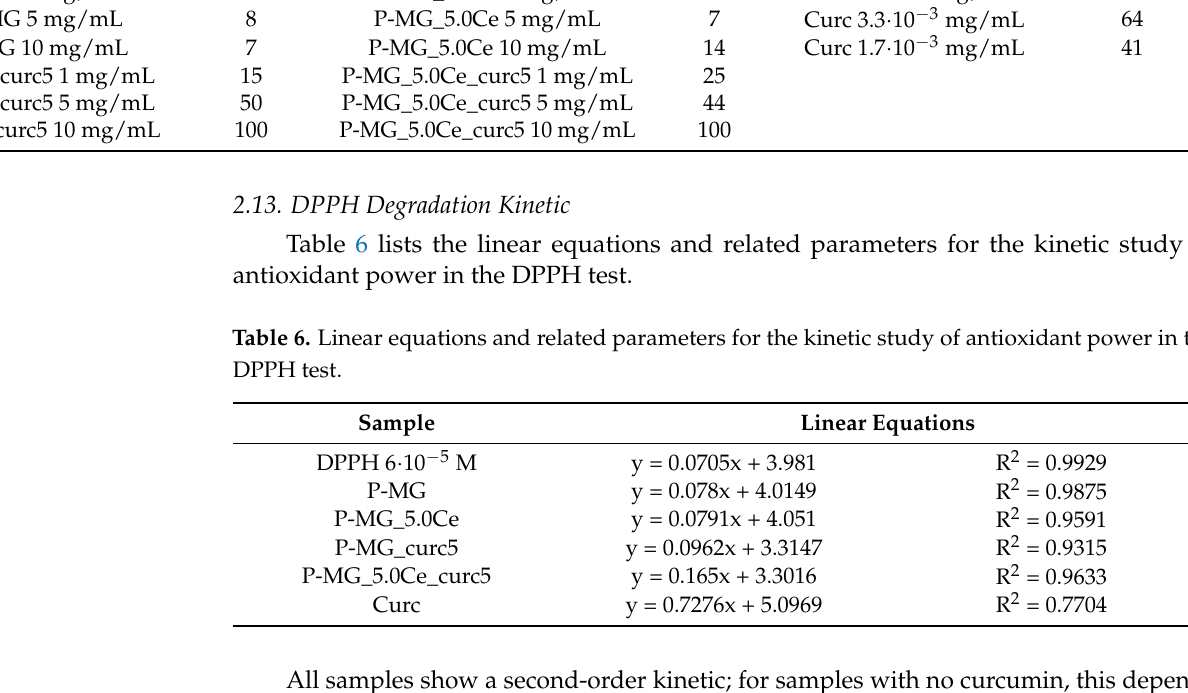
Table 5. Radical scavenging effect of some samples tested to evaluate the antioxidant power against the radical DPPH.